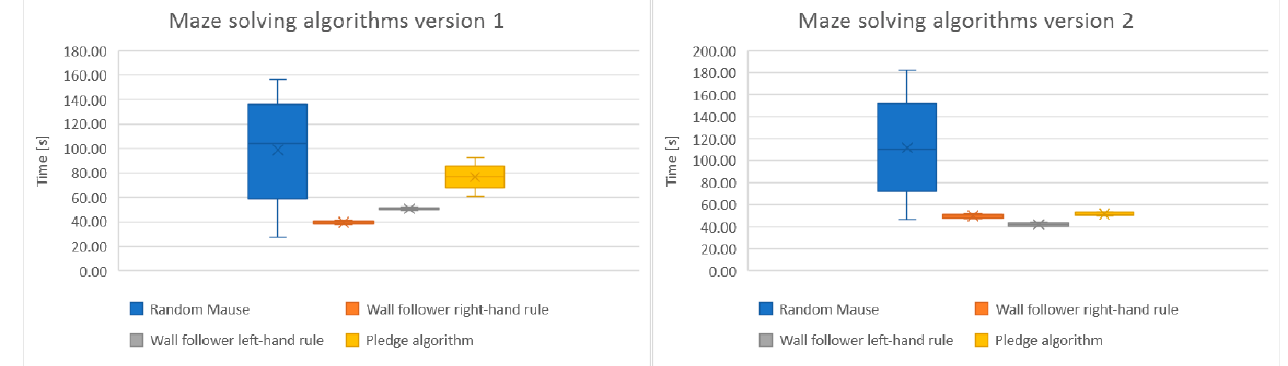
Figure 5. Boxplots comparing individual algorithms in two versions of the maze.